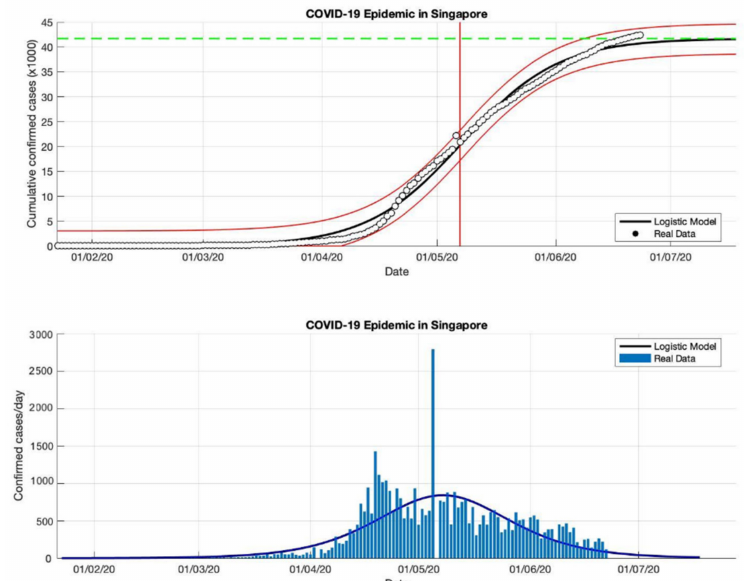
Figure 5. In the above figure, the prediction results of the logistic growth model for cumulative infected cases are compared with the actual data, while the two red lines between the black lines represent a prediction error limit of about 5%. The dashed green line predicts the total size of infected cases in the final phase of the epidemic. The red line intersects the cumulative case curve to predict the turning point or peak point of the epidemic (this line is parallel to the top of the curve from the below figure). In the below figure, the prediction results of this model for daily infected cases